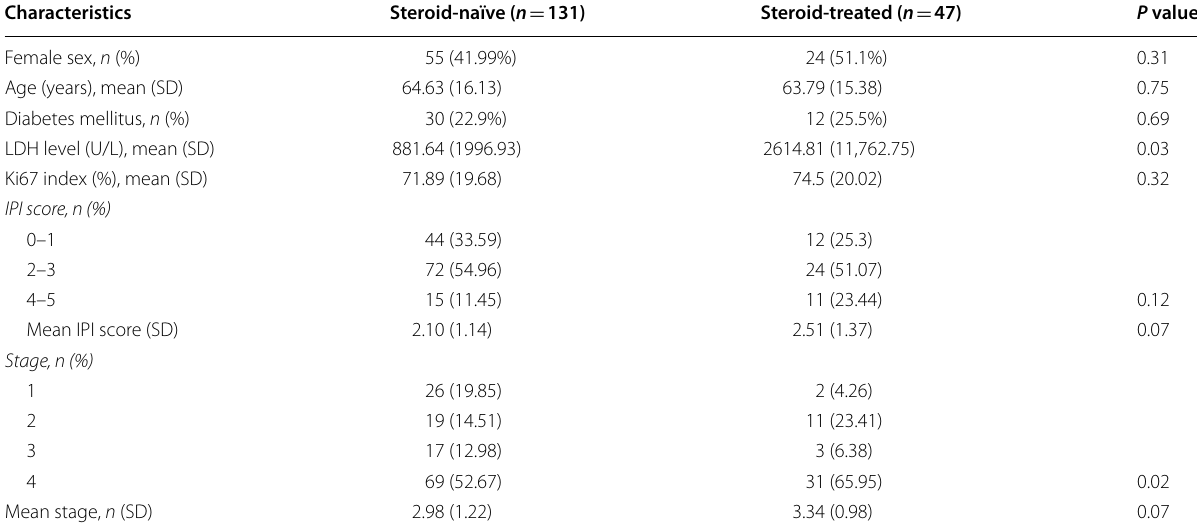
LDH lactate dehydrogenase, IPI international prognostic index